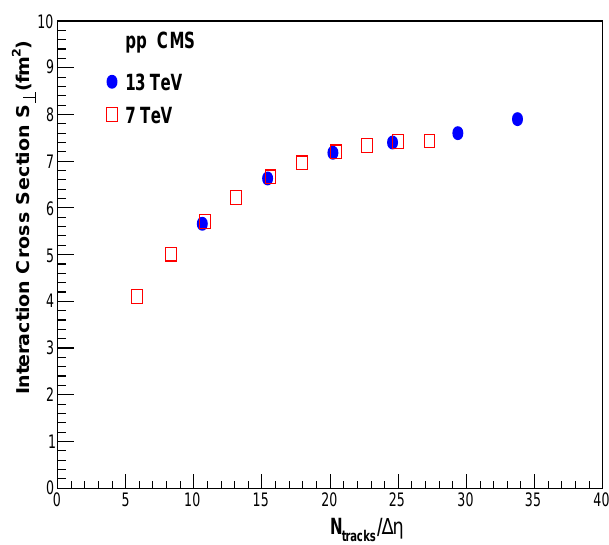
Figure 6. Interaction cross section S ⊥ vs. N tracks / ∆ η . S ⊥ is obtained using IP-Glasma model [22].